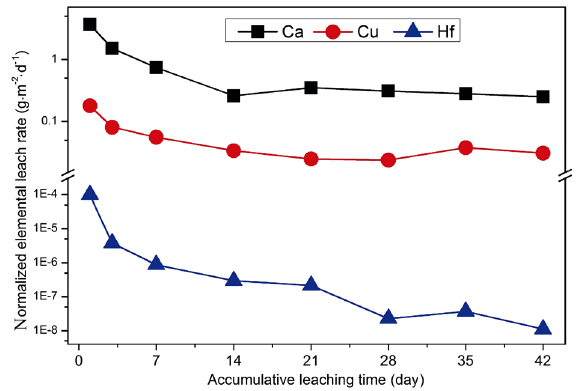
Fig. 8 1–42-day normalized leaching rates of the Cu-Hf-0.6 sample for the Ca, Cu, and Hf